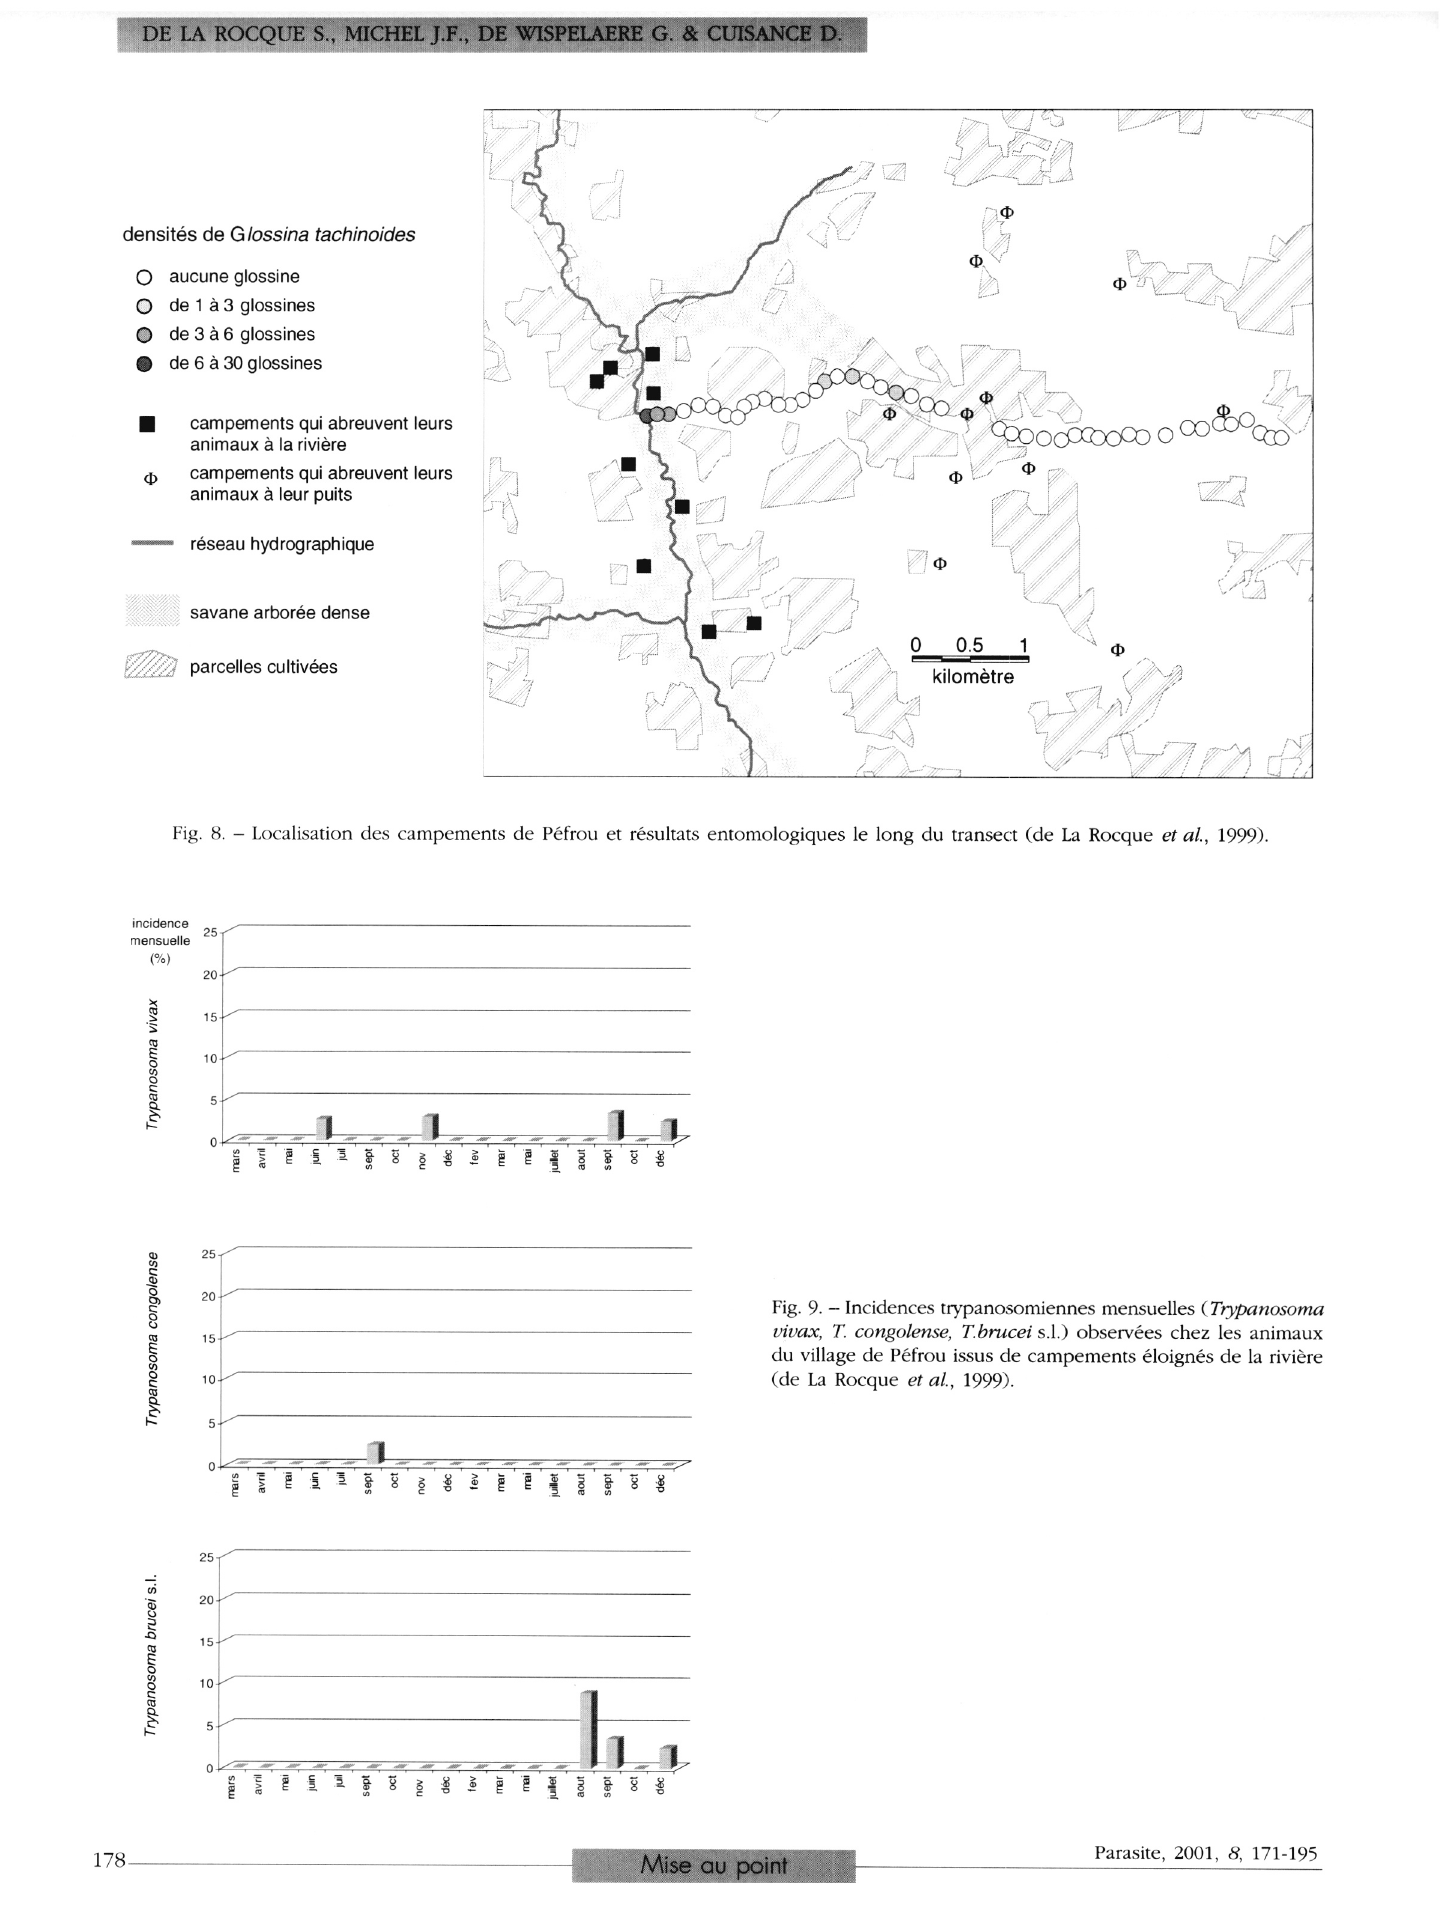
Fig. 9- - Incidences trypanosomiennes mensuelles (Trypanosoma vivax, T. congolense, T.brucei s.l.) observées chez les